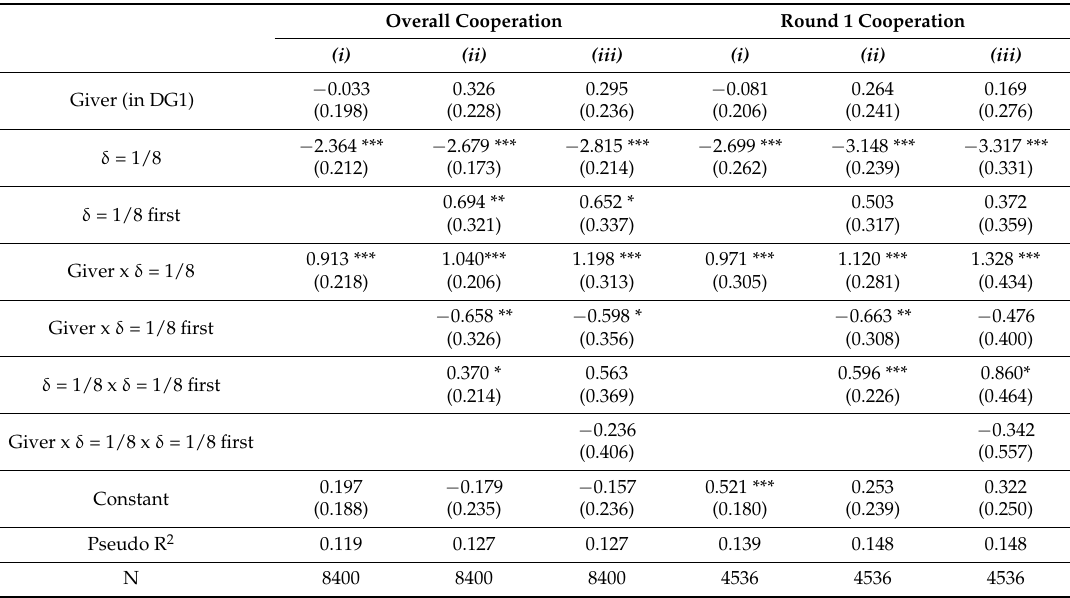
Table 4. Cooperation in the Prisoner’s Dilemma.